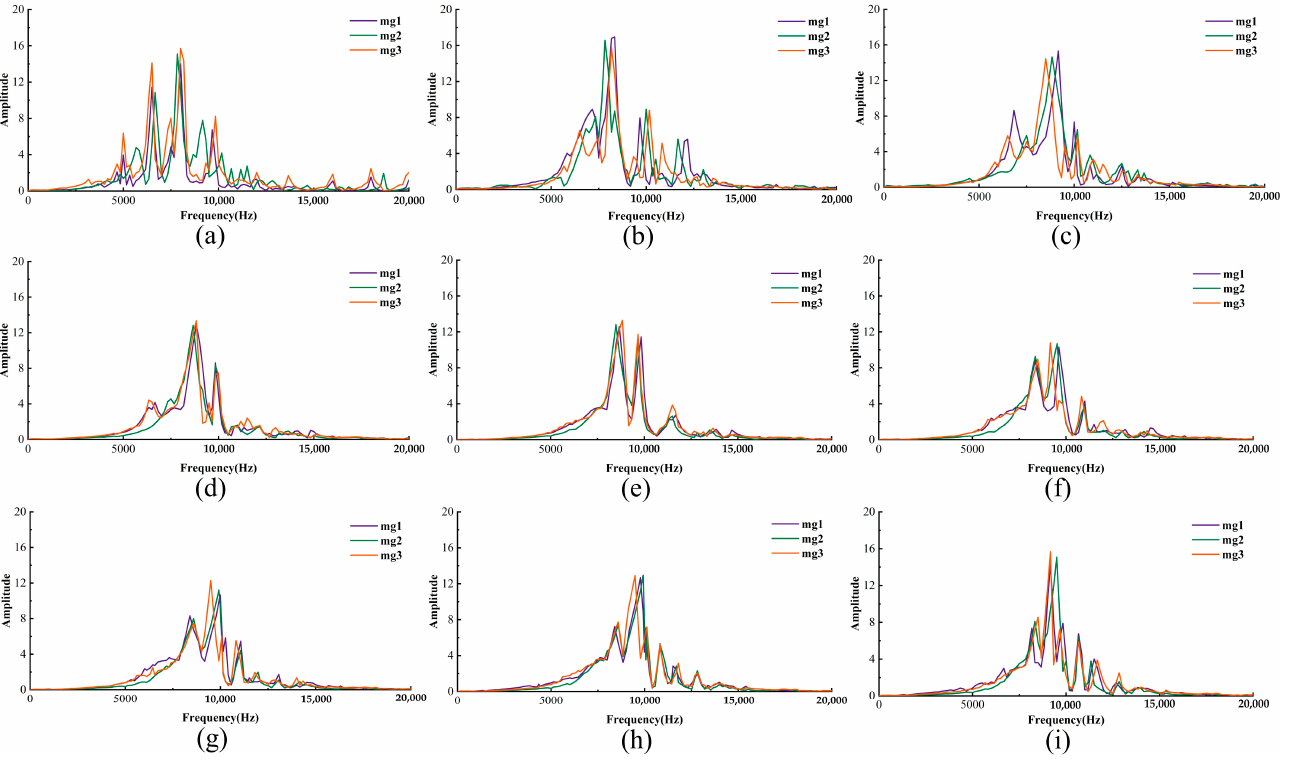
Figure 12. Frequency domain diagram of the stress wave signal at different stages of bolt tension. ( a ) Unstretched; ( b ) Elastic stage; ( c ) Yield stage; ( d – f ) Strengthening stage; ( g – i ) Necking fracture stage.